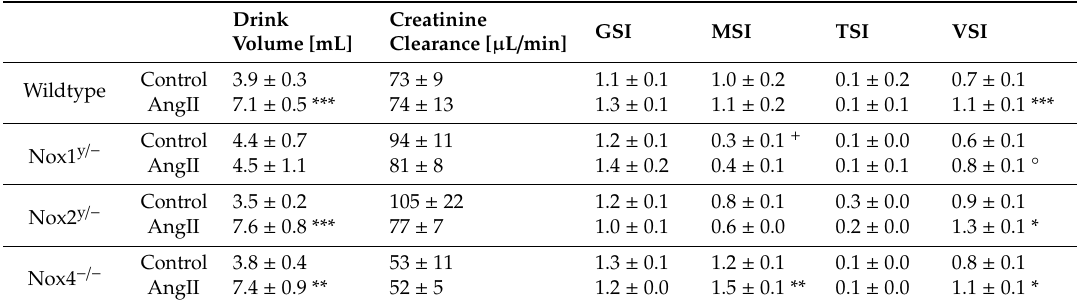
Table 2. Drink volume, creatinine clearance, and histological parameters.